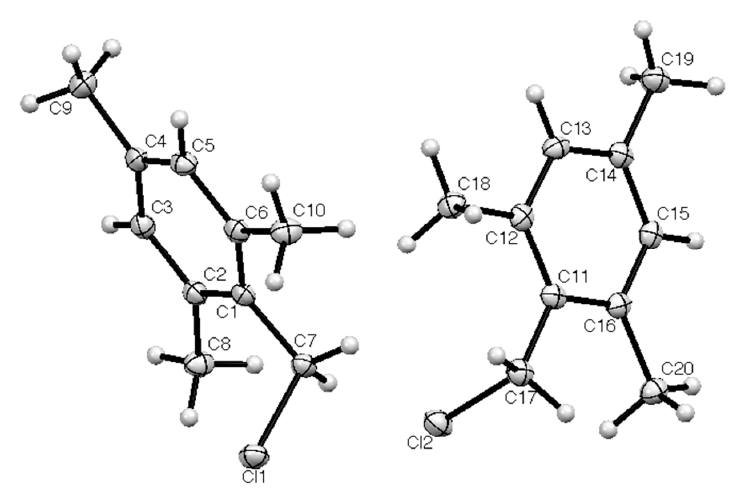
Figure 1. Molecular structures of 1 with anisotropic displacement ellipsoids drawn at 50% probability level.